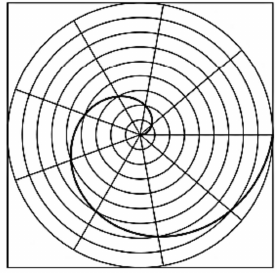
Figure 1. Quadrature of a